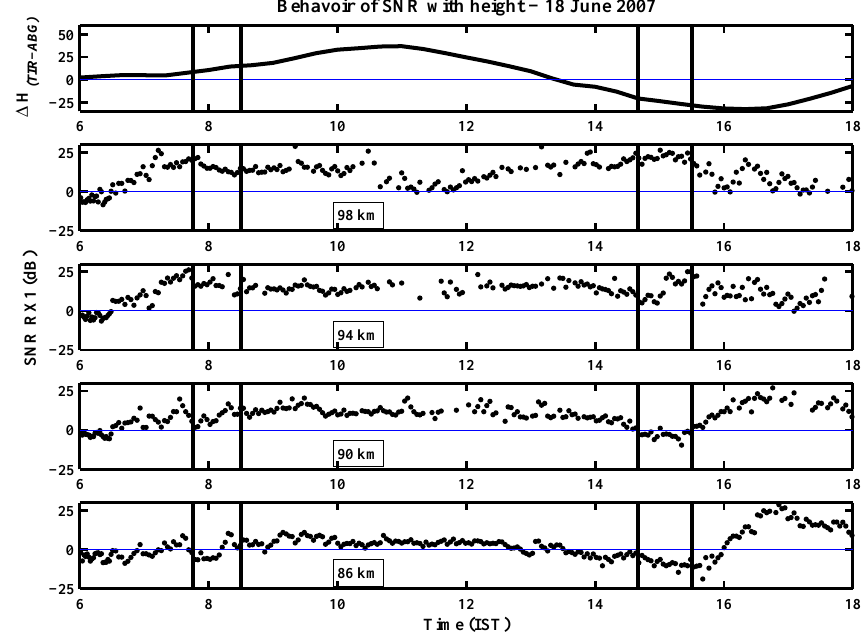
Fig. 3a. Same as Fig. 2a but for 18 June